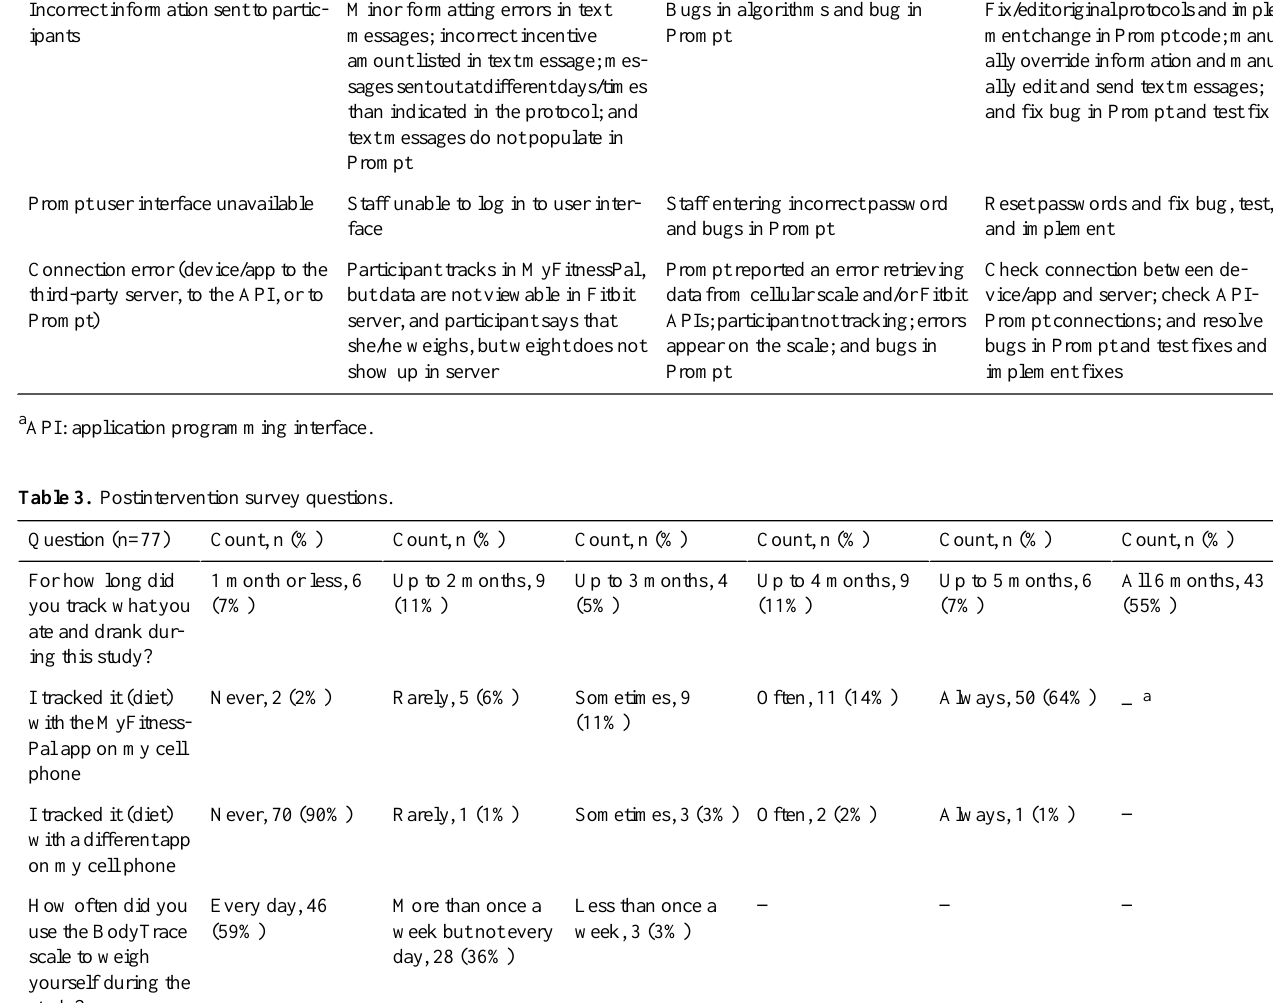
Solution or solutions implementedPotential problemExample of issueIssue type Retrain participant on correct track- ing methods; check connection be- tween device/app and third-party